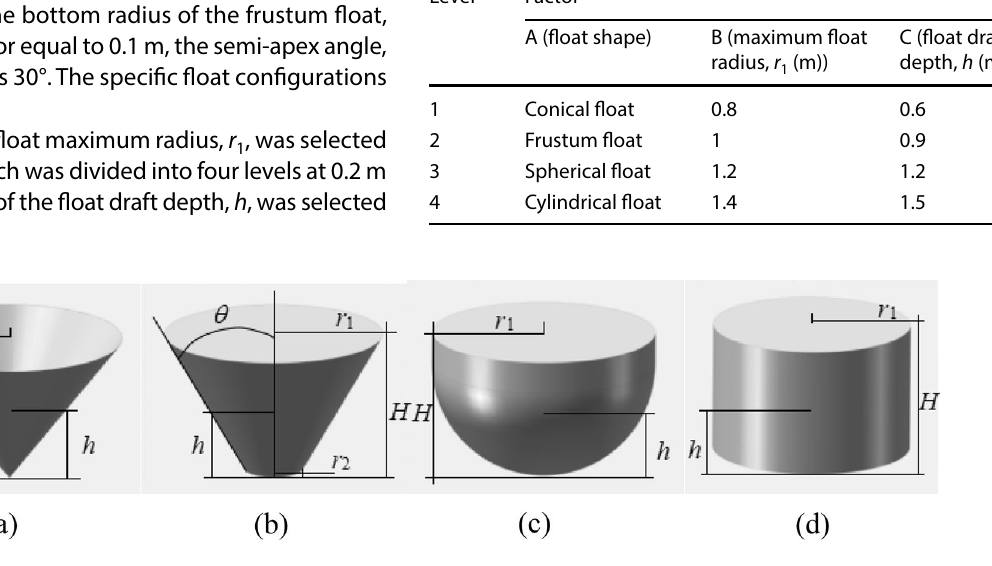
Fig. 2 Float model shapes: a conical, b frustum, c spherical, and d cylindrical